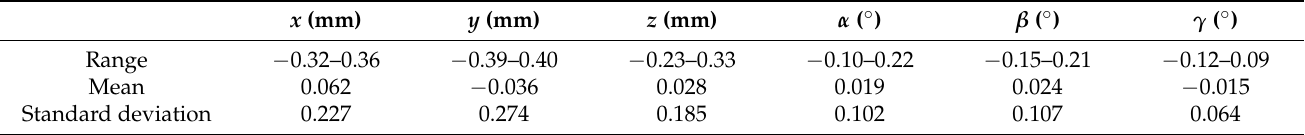
Table 1. Pose recognition errors of the model